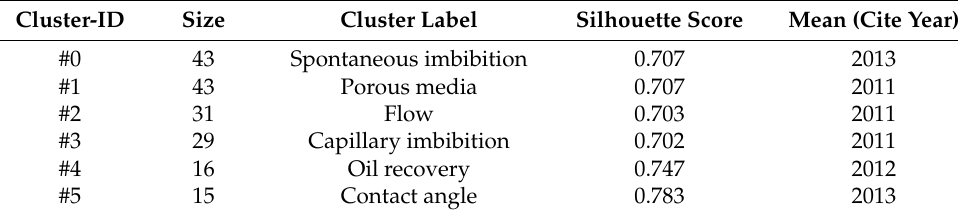
Table 5. Six main clusters in imbibition studies.